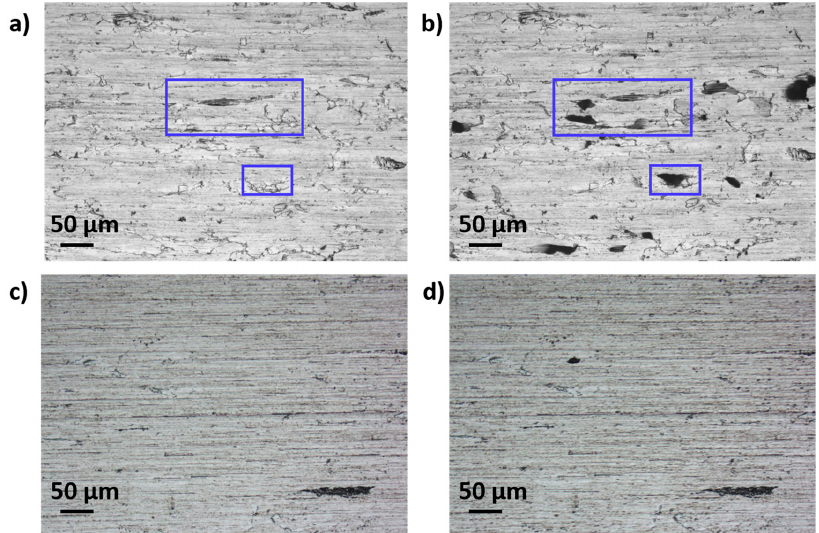
Figure 2. Optical microscopy images of the surface of the FSS1 sample ( a ) before and ( b ) after the tape test. The two blue rectangles indicate flakes that were detached during the tape test. Optical microscopy images of the surface of the FSS2 sample ( c ) before and ( d ) after the tape test.